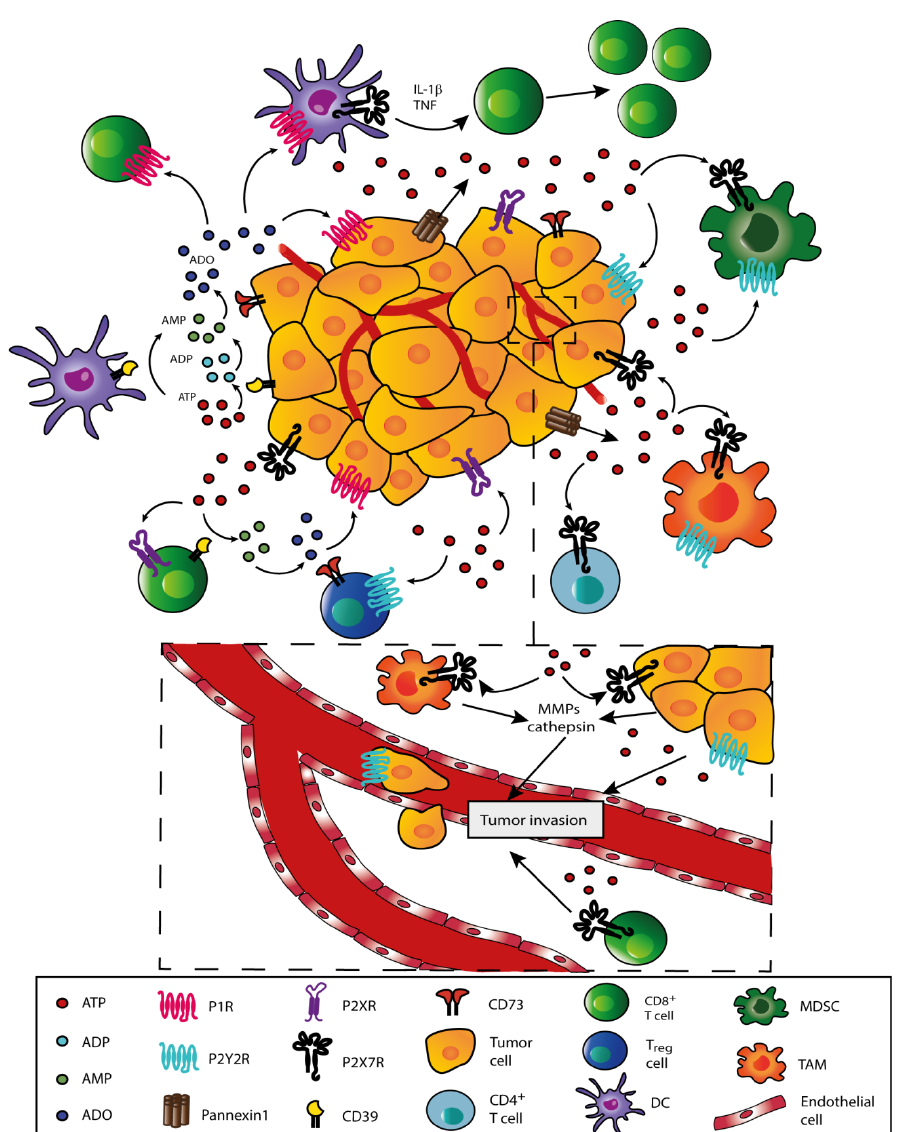
Figure 2. Extracellular ATP shapes the TME. ATP is released into the tumor microenvironment (TME) in a non-regulated or regulated fashion. Extracellular ATP can promote immunosuppression or support antitumor immunity depending on its concentration and specific receptors expressed by immune and cancer cells. ATP is degraded by ecto-nucleotidases (CD39 and CD73) to generate ADP, AMP and adenosine (ADO), which promote immunosuppression via adenosine receptors P1 (P1Rs) (mainly A2AR and A2BR). A2AR stimulation inhibits antigen presentation by dendritic cells (DCs) and impairs cytotoxic T lymphocytes functions. Extracellular ATP acting at P2Y receptors (P2Y1R, P2Y2R or P2Y6R) and P2X receptors (mainly P2X7R) supports tumor cell survival and proliferation, but at the same time drives recruitment and activation of immune cells such as CD8 + and CD4 + T lymphocytes, T regs , tumor-associated macrophages (TAMs) and myeloid-derived suppressor cells (MDSCs). In